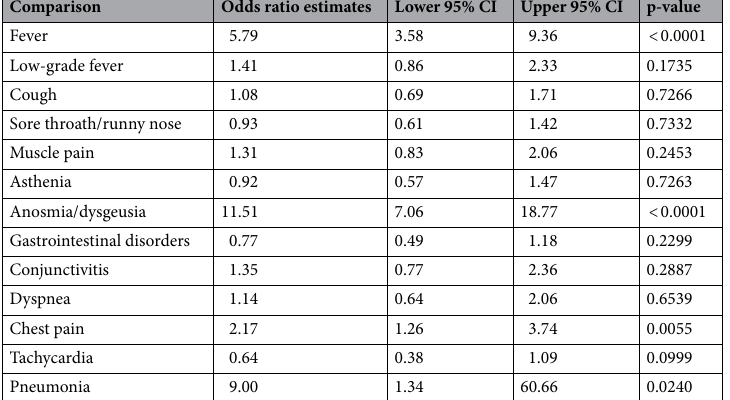
Table 6. Multilevel Logistic model for symptoms adjusted for professional status, age, gender and their interaction, smoking habits, BMI.